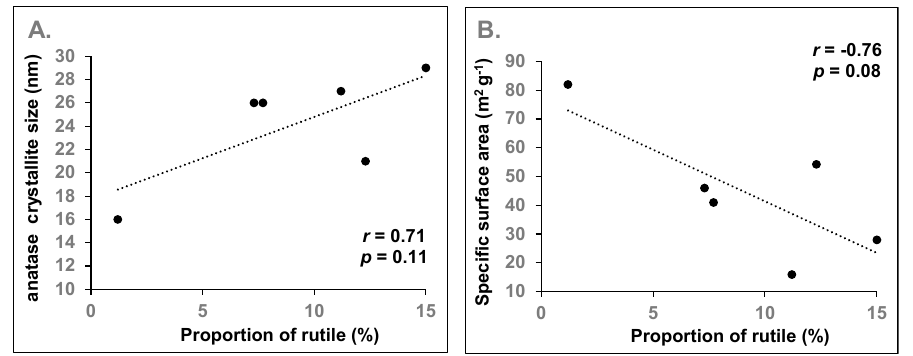
Figure 3. Correlation between ( A ) the average crystallite size of anatase and ( B ) the measured specific surface area of the nanopowder and the proportion of rutile in anatase/rutile mixtures with a low amount of rutile ( ≤ 15% of total TiO 2 ); r is the Pearson’s correlation coe ffi cient and p is the probability